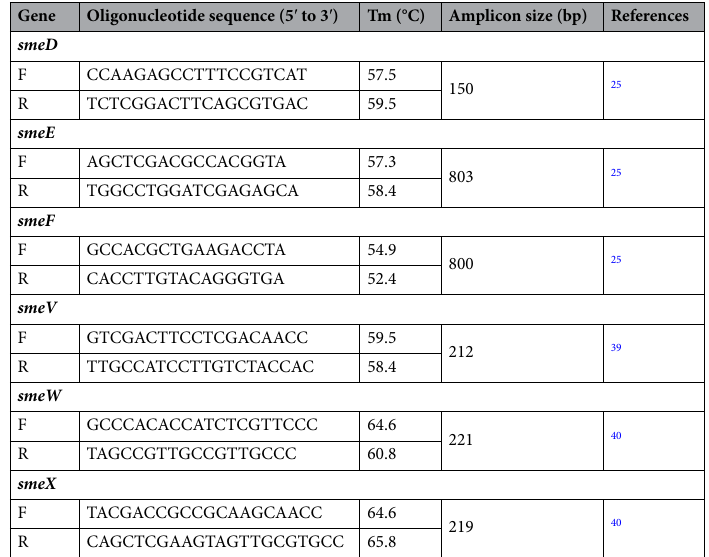
Table 2. Primers used in PCR detection of smeDEF and smeVWX genes in Stenotrophomonas maltophilia strains. F forward, R